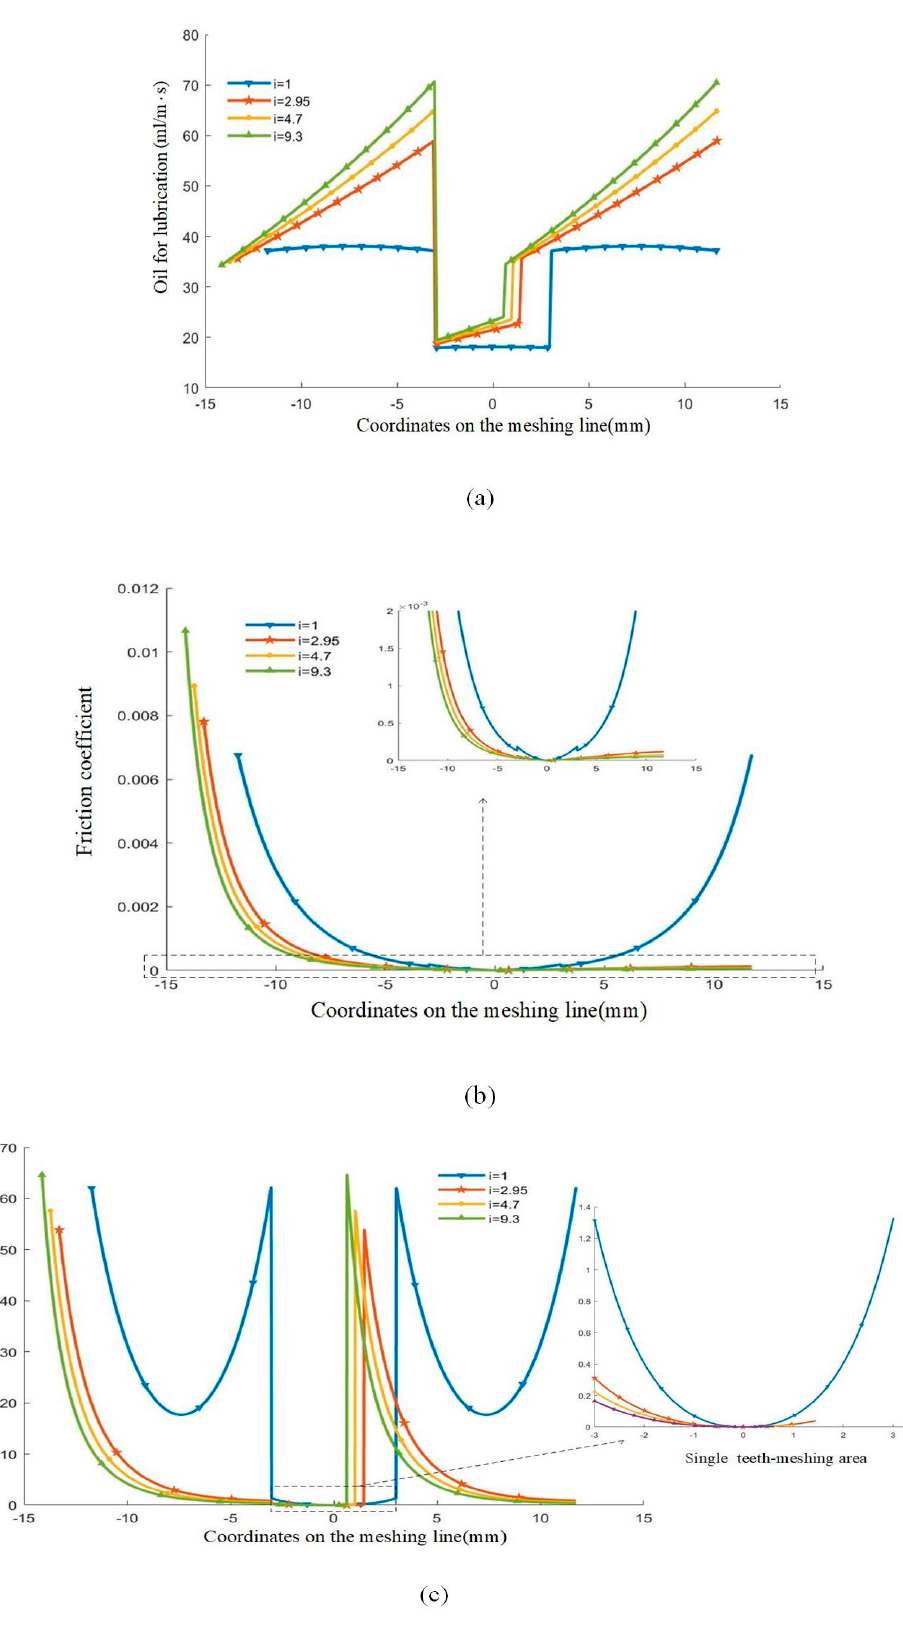
Figure 8. Oil volume for lubrication ( a ), friction coefficient ( b ), and oil volume for cooling ( c ) under different transmission ratios during the meshing process.